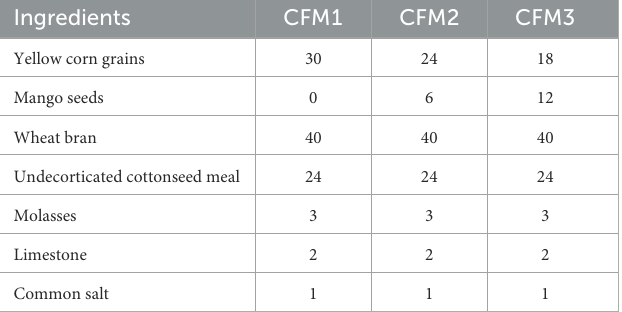
TABLE 1 Formulation of different concentrate feed mixtures (CFM, % on DM basis).